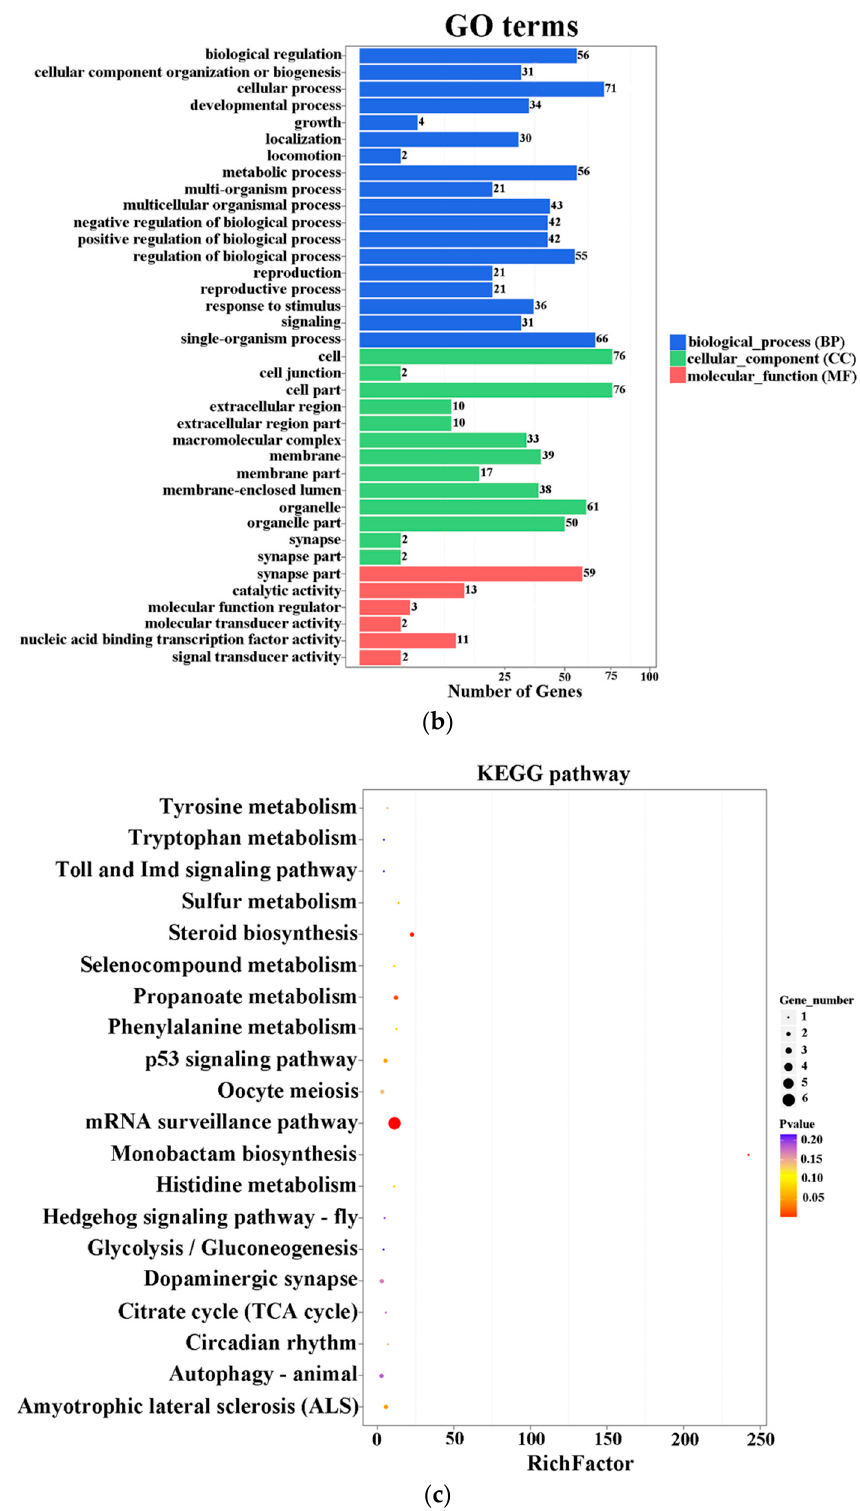
Figure 3. Functional analysis of target genes of DEMs. ( a ) DEMs target gene network associated with development and metabolism of skeletal muscle in rabbits. Colors represent target gene groups regulated by seven DEMs. ( b ) Enrichment analysis of target gene Gene Ontology (GO) functions and ( c ) Kyoto Encyclopedia of Genes and Genomes (KEGG) signaling pathways from DEMs in skeletal muscle from CON–G and HFD–G rabbits.